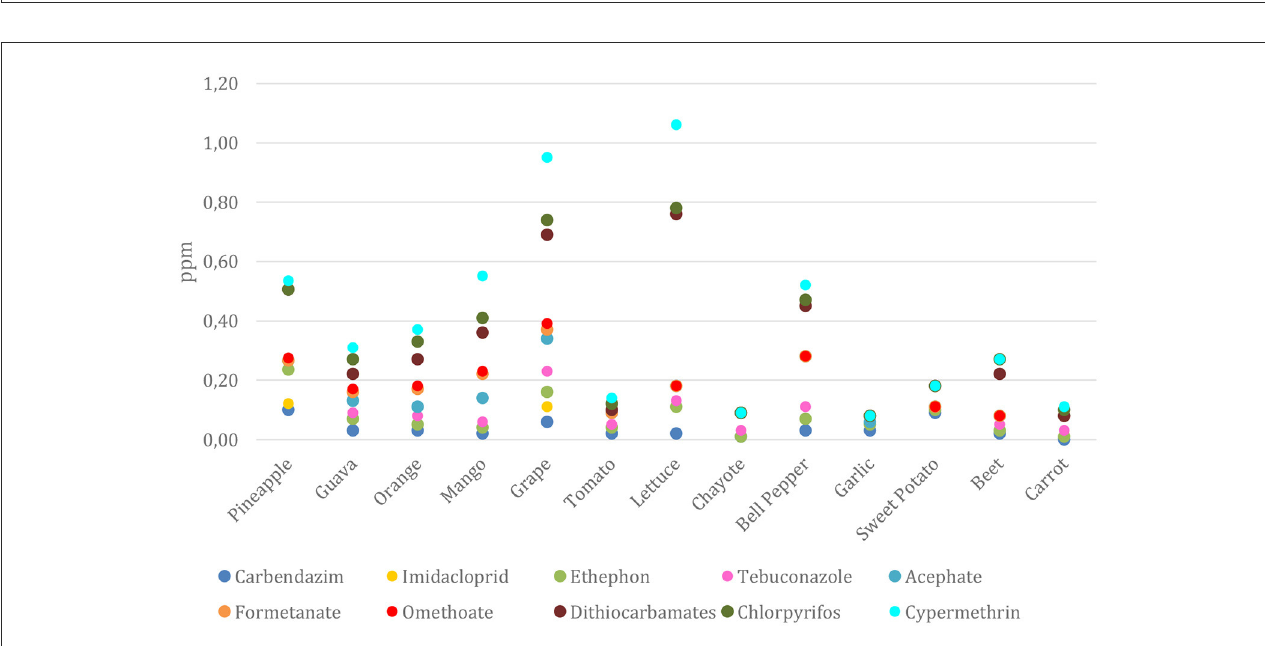
FIGURE2 Main pesticide residues detected in PARA 2017–2018: median of values detected per culture (mg/kg).